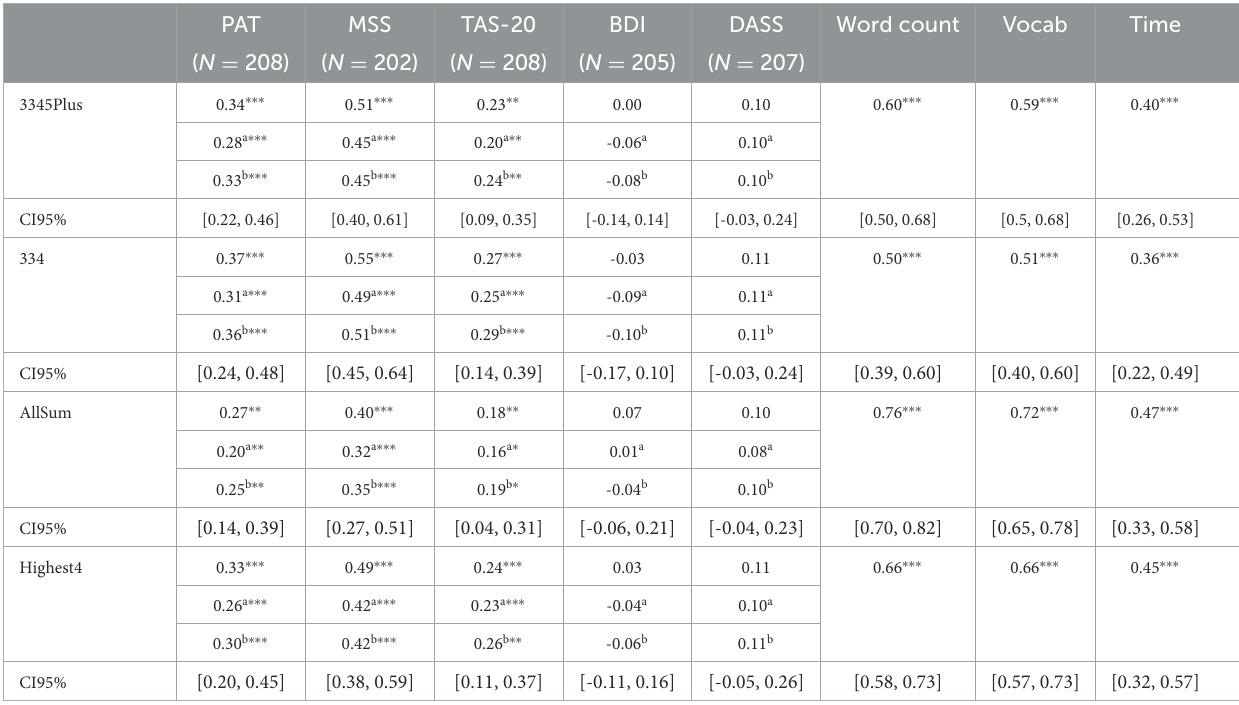
TABLE 7 Correlations of scoring methods with psychometric test